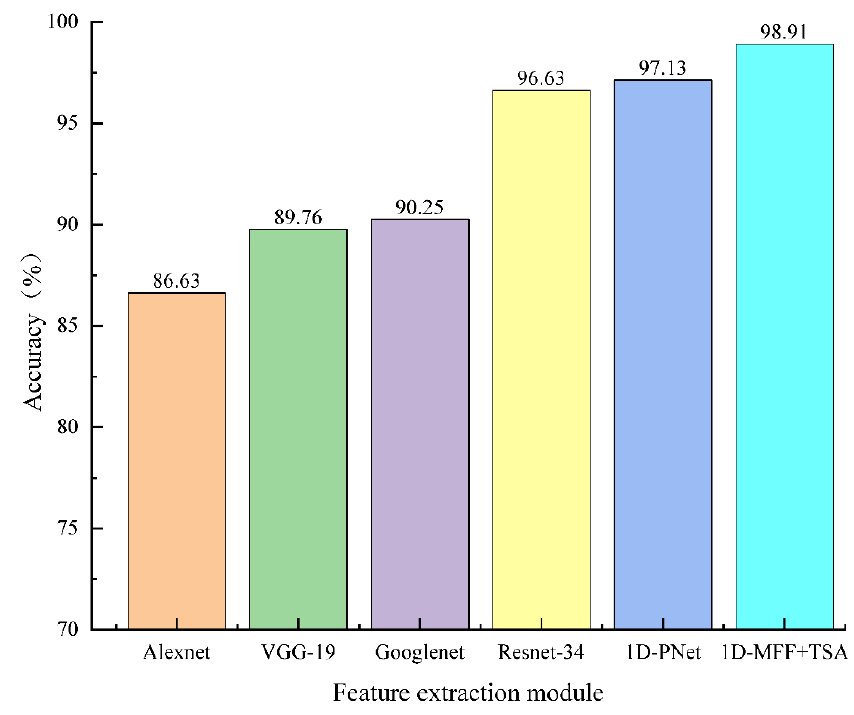
Figure 8. Recognition rate of different networks as feature extraction module.